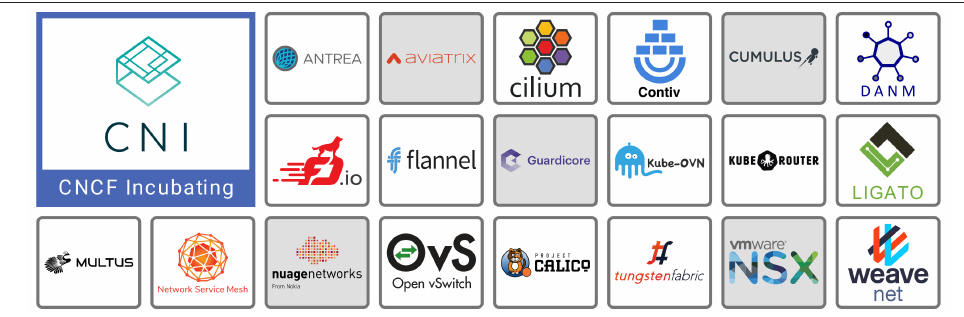
Figure 1: CNCF Cloud Native Networking